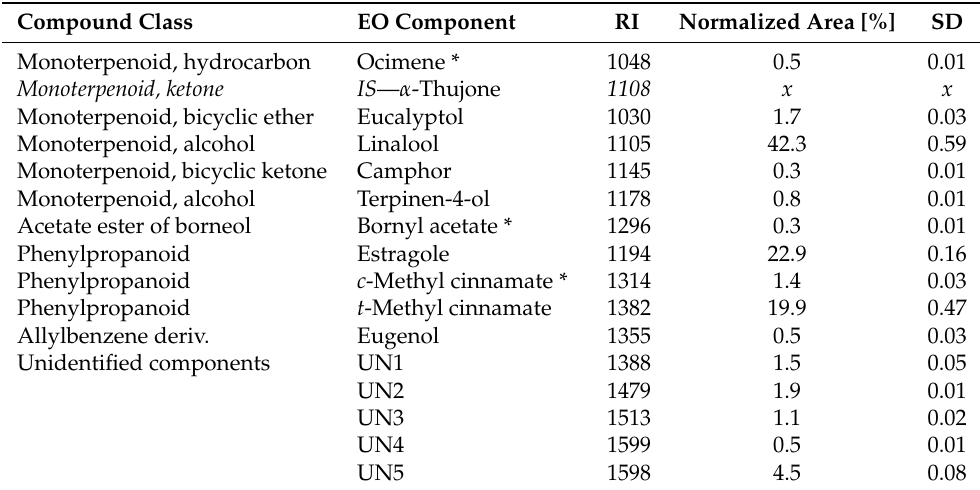
Table 1. Qualitative and quantitative analysis of Ocimum sanctum essential oil by GC-MS.